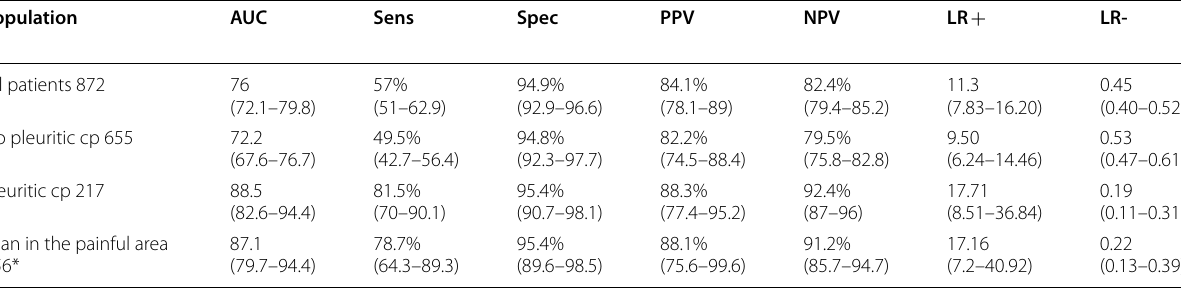
pos positive, neg negative * Patients with pleuritic chest pain enrolled in the studies Reissig 2001 and Nazerian 2017 Table 4 Diagnostic performance of lung ultrasound for the diagnosis of pulmonary embolism in all patients and in patients without and with pleuritic chest pain